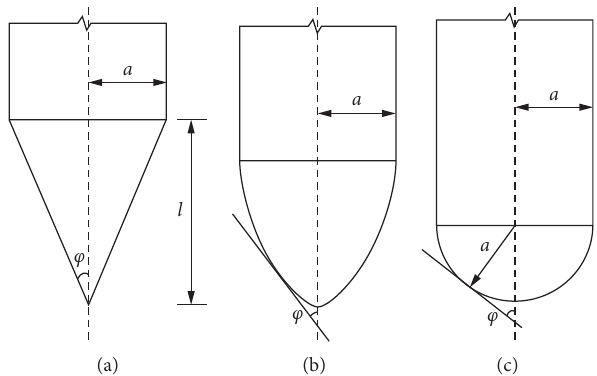
Figure 3: Rigid projectiles with different nose shapes, (a) conical-nosed, (b) sharp-nosed, and (c)